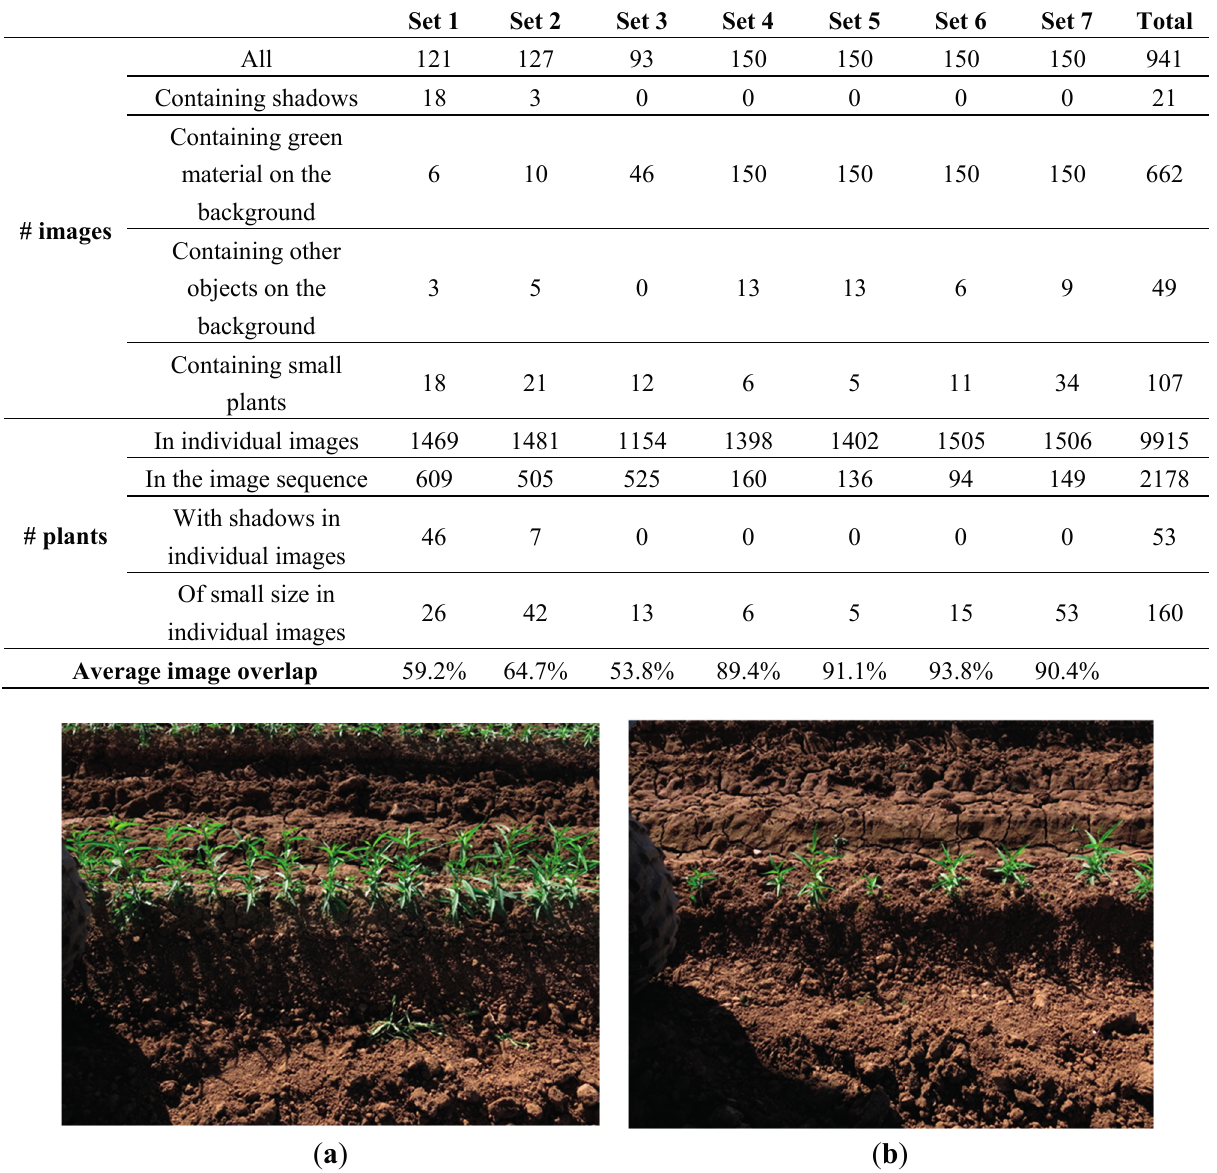
Table 1. List of datasets and their detail information for experiments.